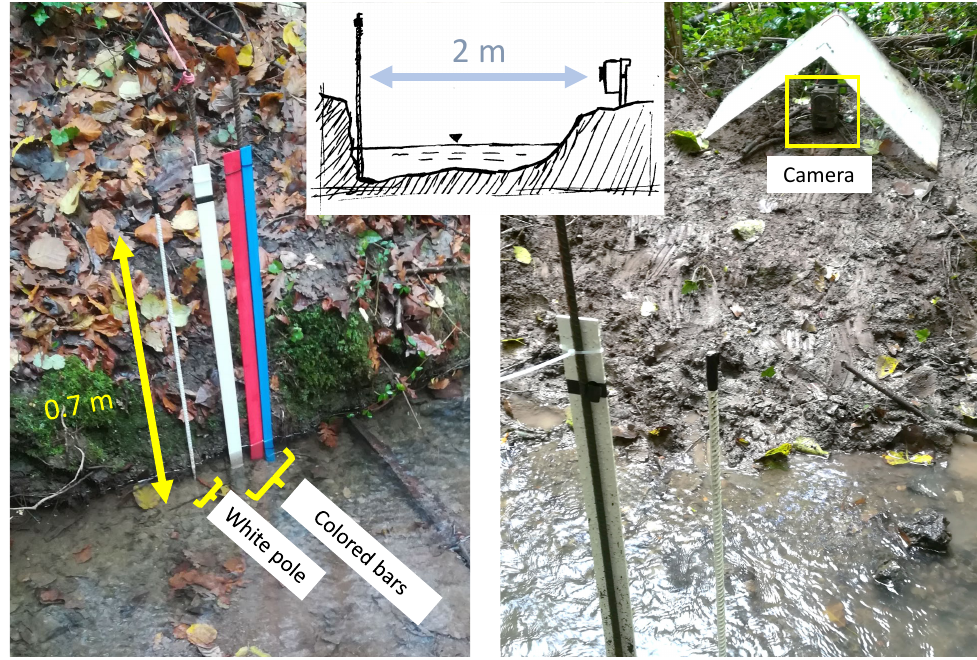
Figure 1. Experimental setup including: white pole, three colored bars, and a wildlife camera. The camera is installed at a stream bank and captures the pole and bars set in the thalweg in the central region of the image. The distance of the pole/bars to the camera is kept within the 5 m range with the pole/bars consistently occupying the central region of the field of view, and, therefore, image geometric correction is not necessary. The camera captures 16 Mpix images in the time-lapse mode at intervals from 3 s to 24 h. At night, high image visibility is afforded through shooting in the NIR band (850–940 nm). Power loading is enabled through eight rechargeable AA batteries. The camera is tied to a 1-m-long grounding bar through straps and installed on a river bank at a few decimetres from the river. The grounding bar is fully fixed into the ground to ensure image stability. The camera is set at a distance of 2–4 m from the pole and bars, with its axis roughly perpendicular to the longitudinal axis of the river bed. Care is taken in focusing the pole and bars at the camera’s image center and in positioning the stage-camera system so as to prevent direct sunlight from entering the objective as well as target vibrations. Images are either 4640 × 3480 pixels or 4032 × 3024 pixels in spatial resolution, which leads to a pixel length of 0.03–0.06 cm. Images are taken every 30 min, thus guaranteeing a system runtime of approximately 1 month, and are then stored in a 32 GB SD